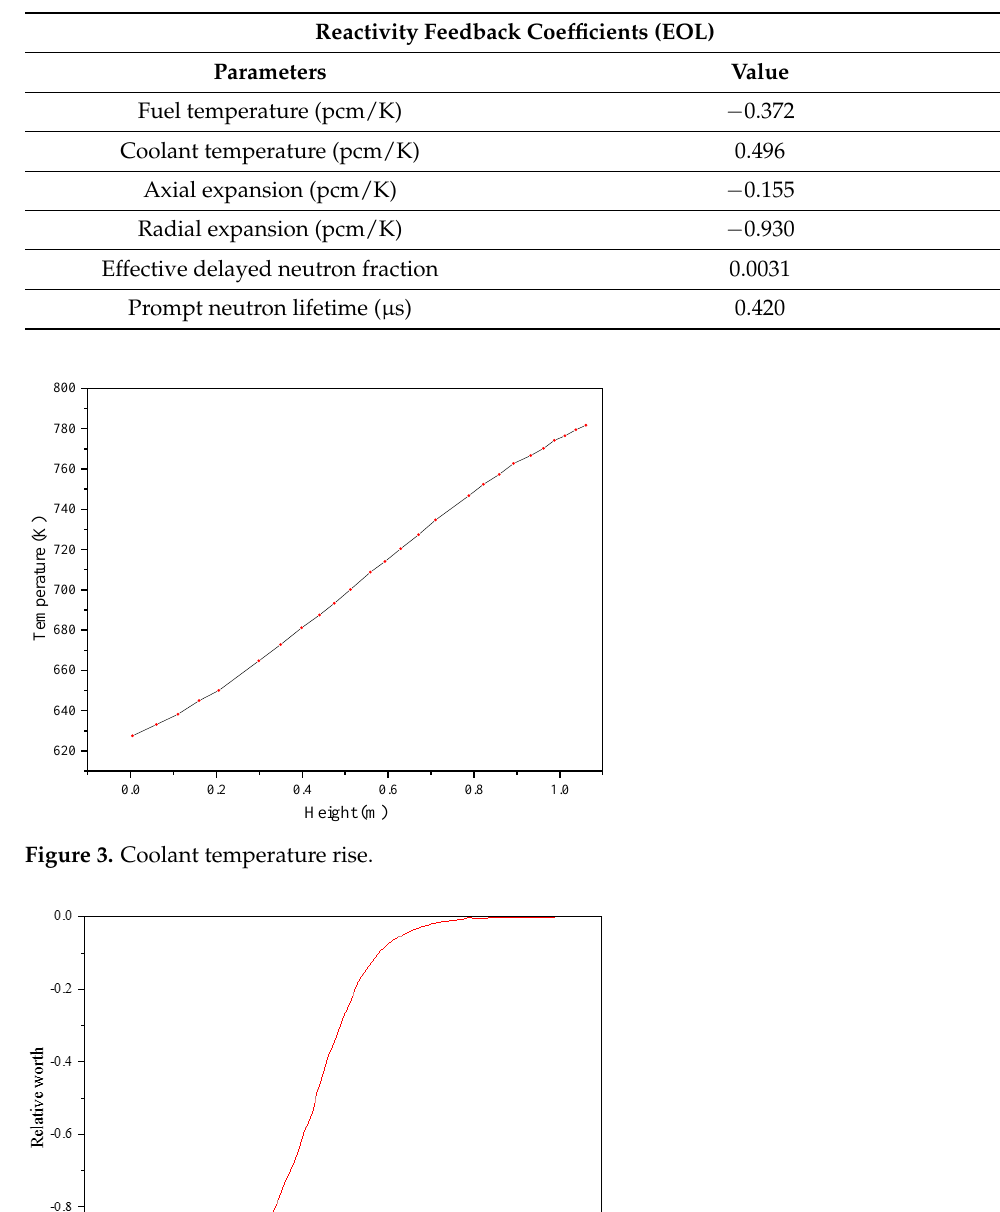
Table 2. Reactivity feedback coefficients of the large-size oxide SFR ABR.